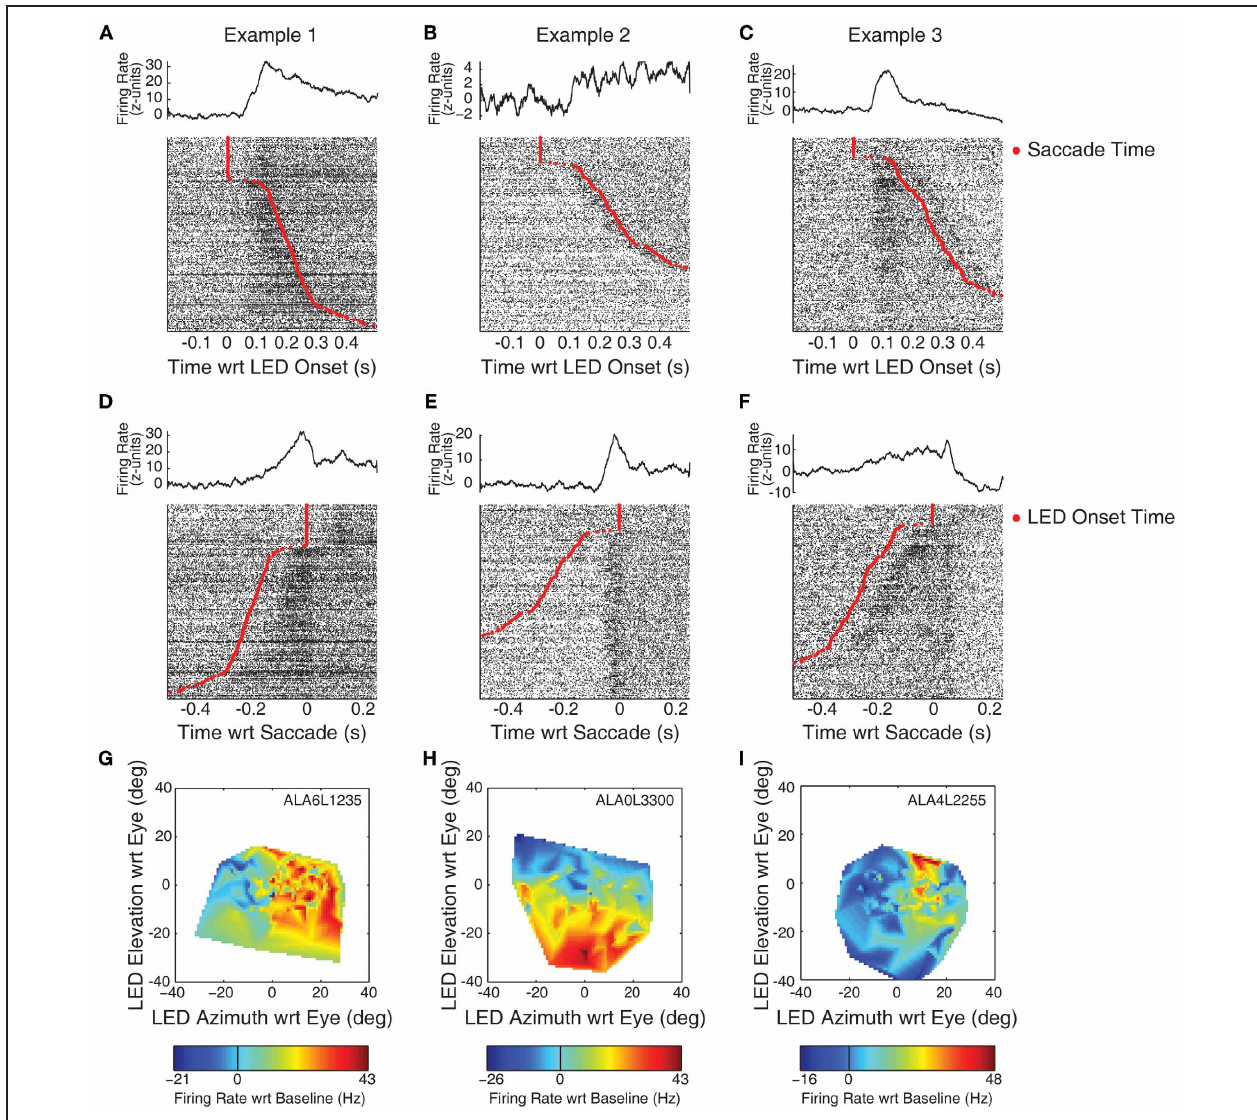
FIGURE 2 | Example recordings with visual and visuomotor related activity. Neural spiking data is plotted for each of three example recording sites in the IC. Panels (A–C) display PSTHs and rasters aligned on the onset of the LED. The time of the saccade is indicated by red points in the rasters. An increase in firing rate, time-locked to the onset of the LED, can be observed in panels (A) and (C) . Panels (D–F) display the same data, but aligned instead on the time at which the monkey’s eyes entered the criterion